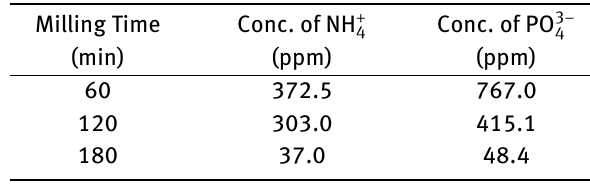
Figure 4. Profile of nutrients release of Kaolin–(NH 4 ) 2 HPO 4 sample mixtures milled for 2 h at different milling speeds and dispersed in distilled water for 24h.